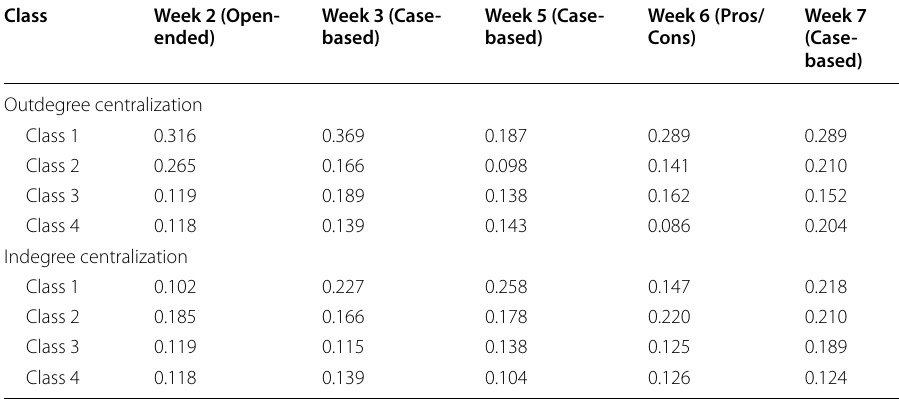
Table 4 Changes in outdegree and indegree centralization on weekly discussion boards